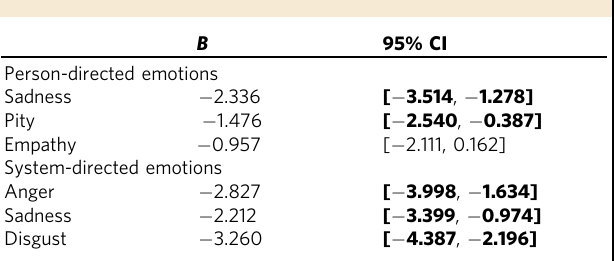
Table 5 Indirect effects of conservatism on